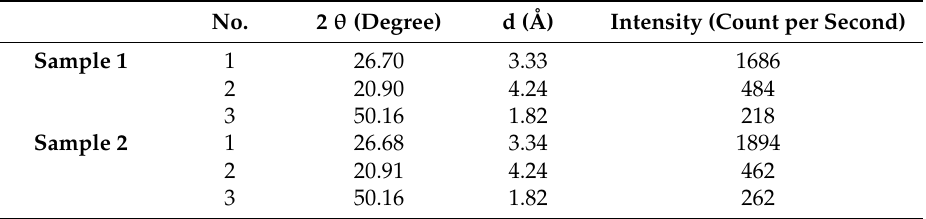
Table 9. The three strongest peaks of X-ray di ff raction laboratory result of the samples. No.